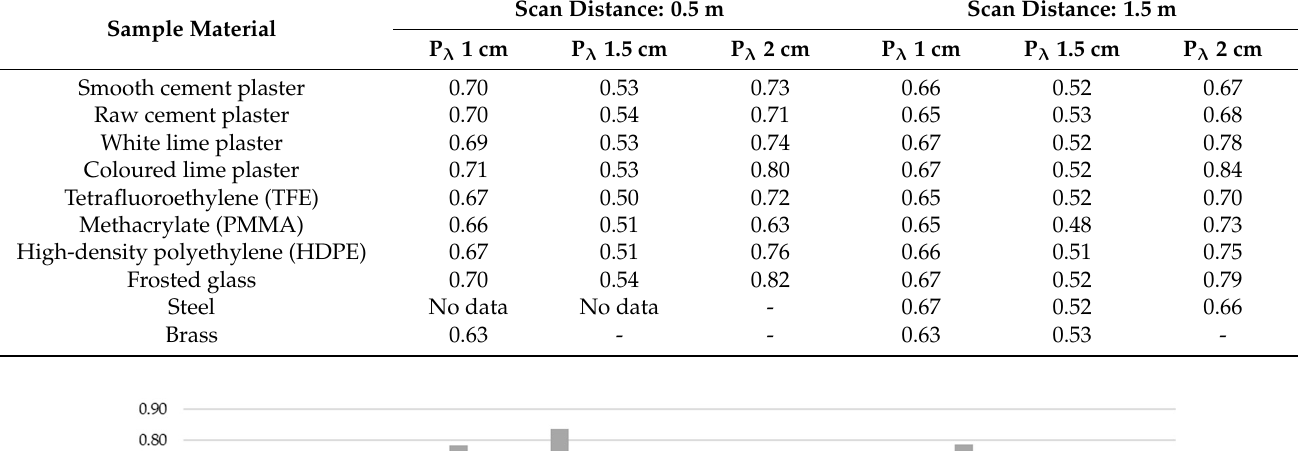
Scan Distance: 0.5 m